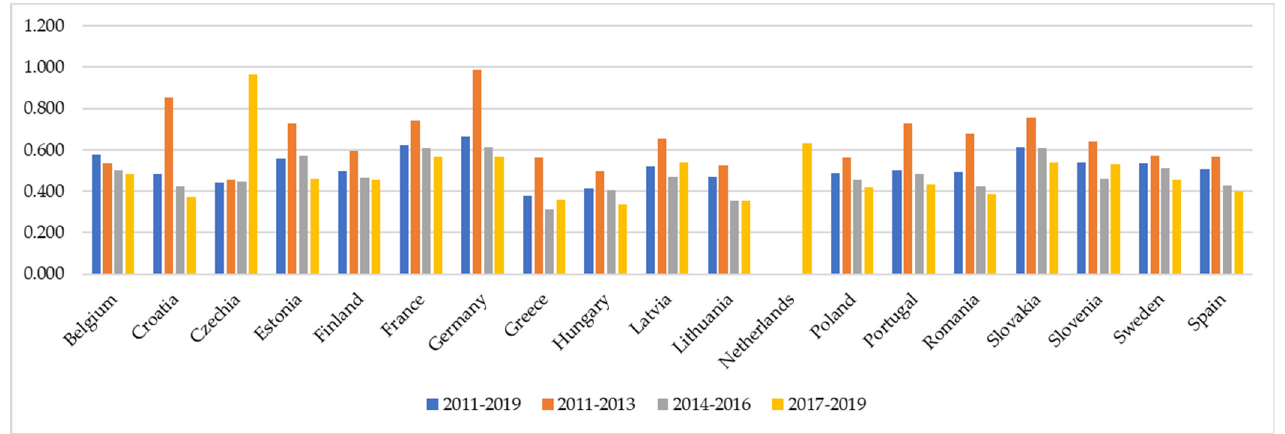
Figure A3. Solvency risk by country, full period, and three sub ‐ periods—low solvency risk category. Note: the graph shows the median values of the TD/SF ratio.